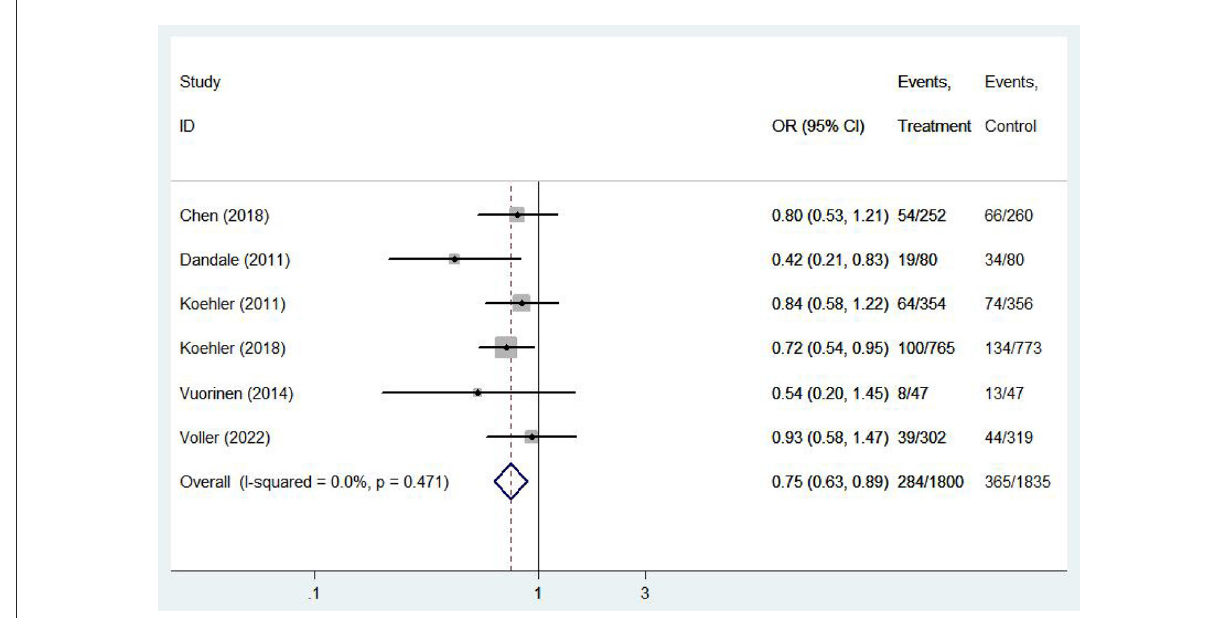
FIGURE8 Forest plots showing the effects of heart failure related hospitalization rate.